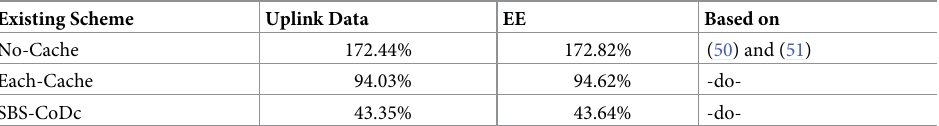
Table 7. Percentage improvement of average AEE.